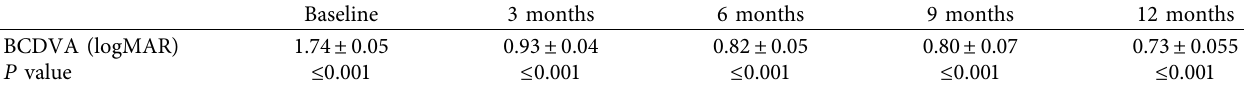
Table 2: BCDVA change overtime.